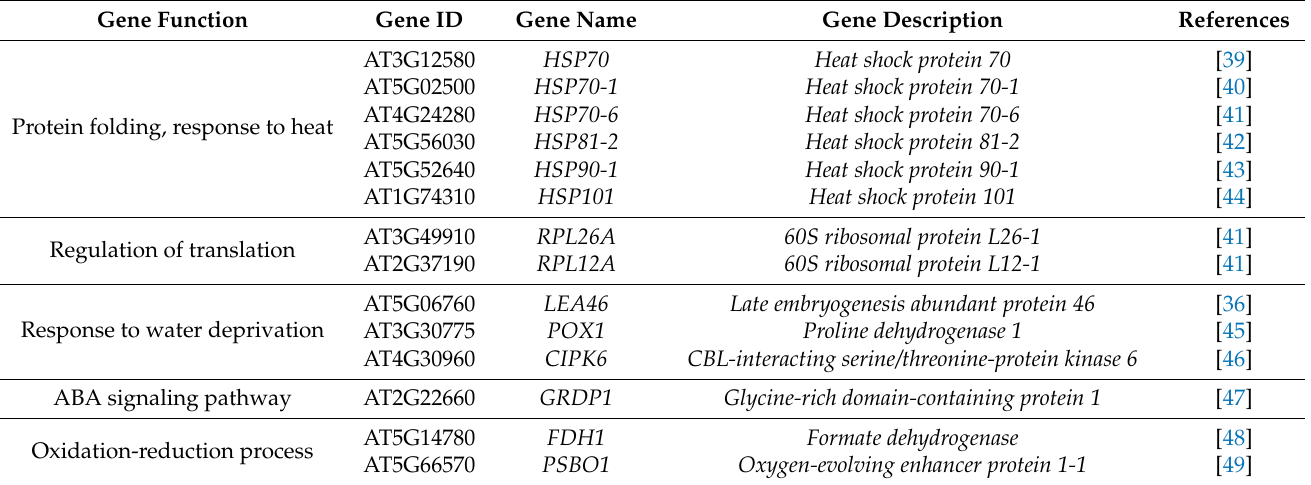
Table 1. Arabidopsis thaliana genes associated with response to stress differentially methylated in gene body under heat stress in all three sequence contexts (CpG, CHG,